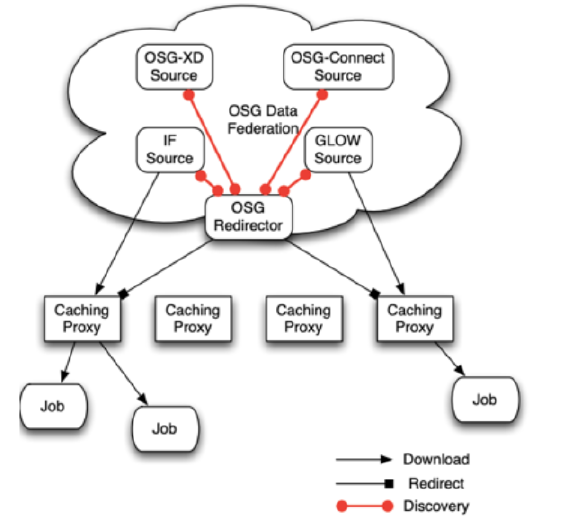
Figure 1. Stashcache